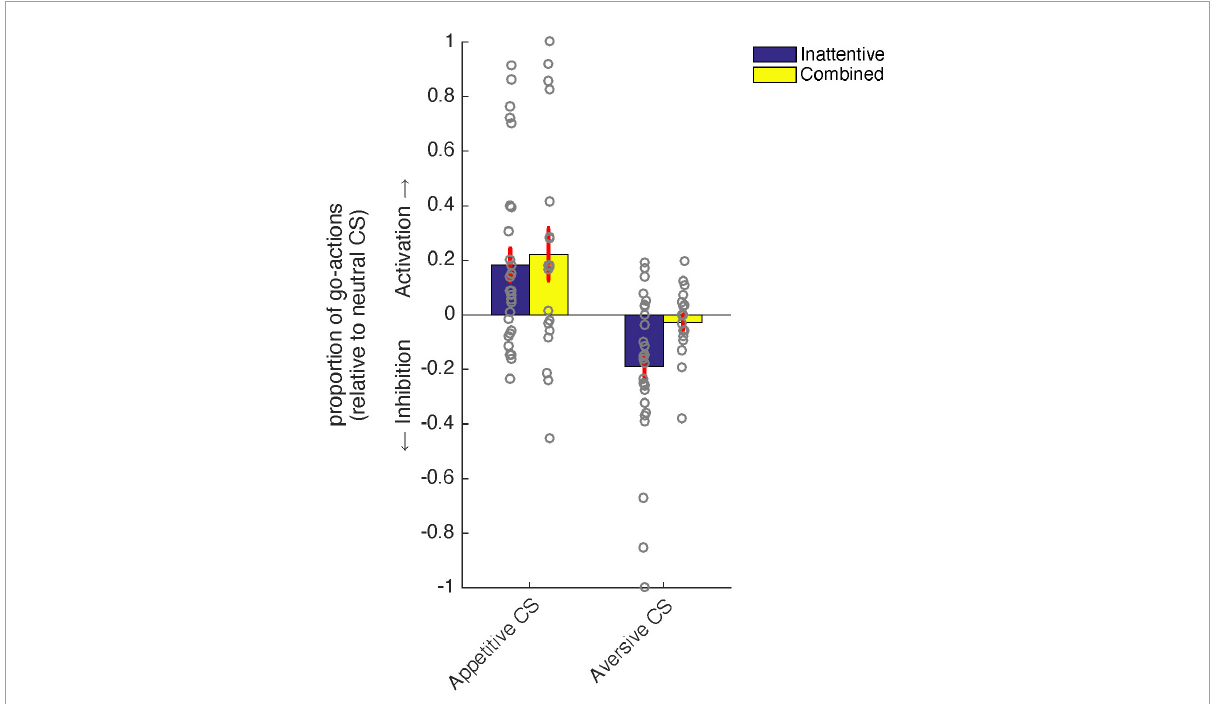
FIGURE2 Relation between ADHD subtype [combined (yellow) vs. inattentive (blue)] and PIT. Patients with the inattentive subtype showed significant aversive inhibition of instrumental behavior in the context of an aversive Pavlovian conditioned stimulus (CS), while this was not the case for patients diagnosed with the combined subtype. There were no differences between ADHD subtypes in terms of appetitive activation of instrumental behavior. Error bars represent standard errors of the